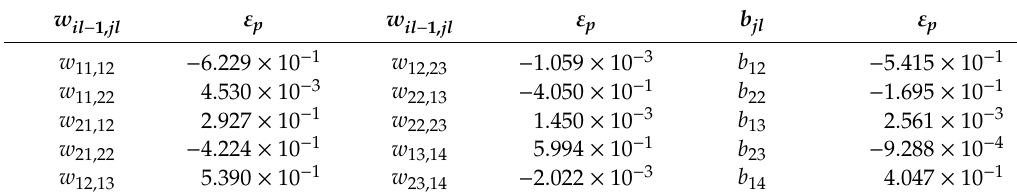
Table 3. Material constants (weights and biases) of the MLP approach for the ε p description.